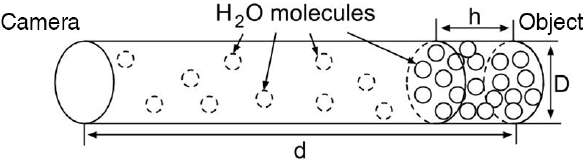
Figure 5. The figure shows the cylinder with height d and diameter D ; it includes amount of water vapour, and it is at the distance of measurement using the thermovision camera (Gaussorgues,